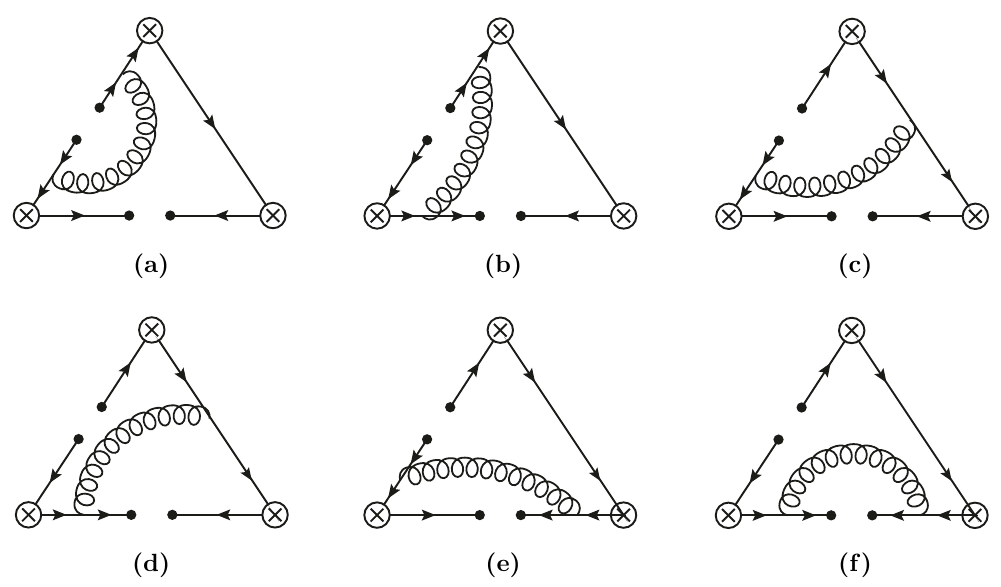
Figure 9. Feynman diagrams of the direct contribution of the four-quark condensate to the three- point Green functions.